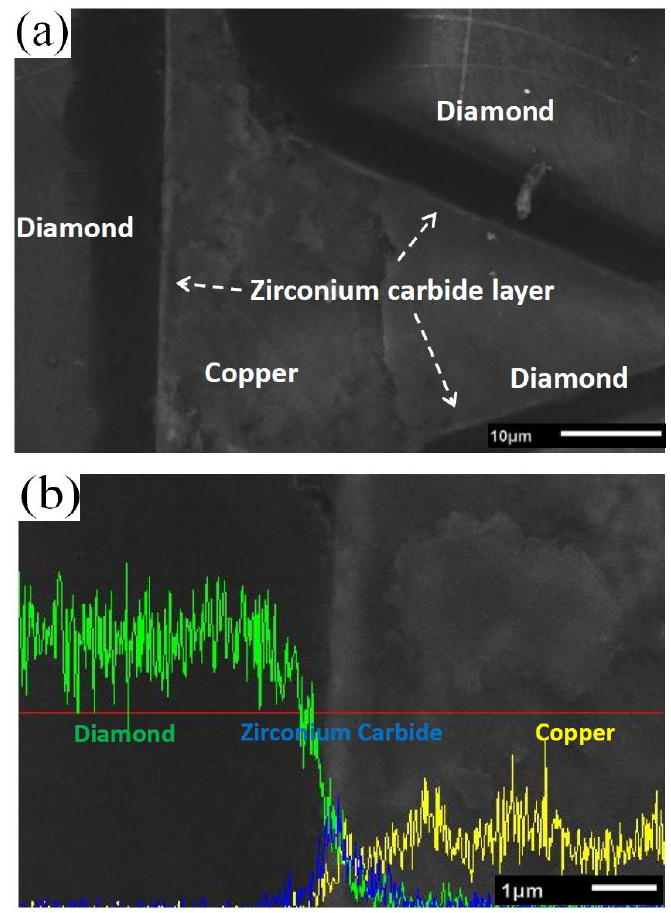
Figure 5. ( a ) The interface ZrC layer of diamond-copper composites; ( b ) EDS interface line-scanning in ZrC/Zr-coated diamond-copper composites.